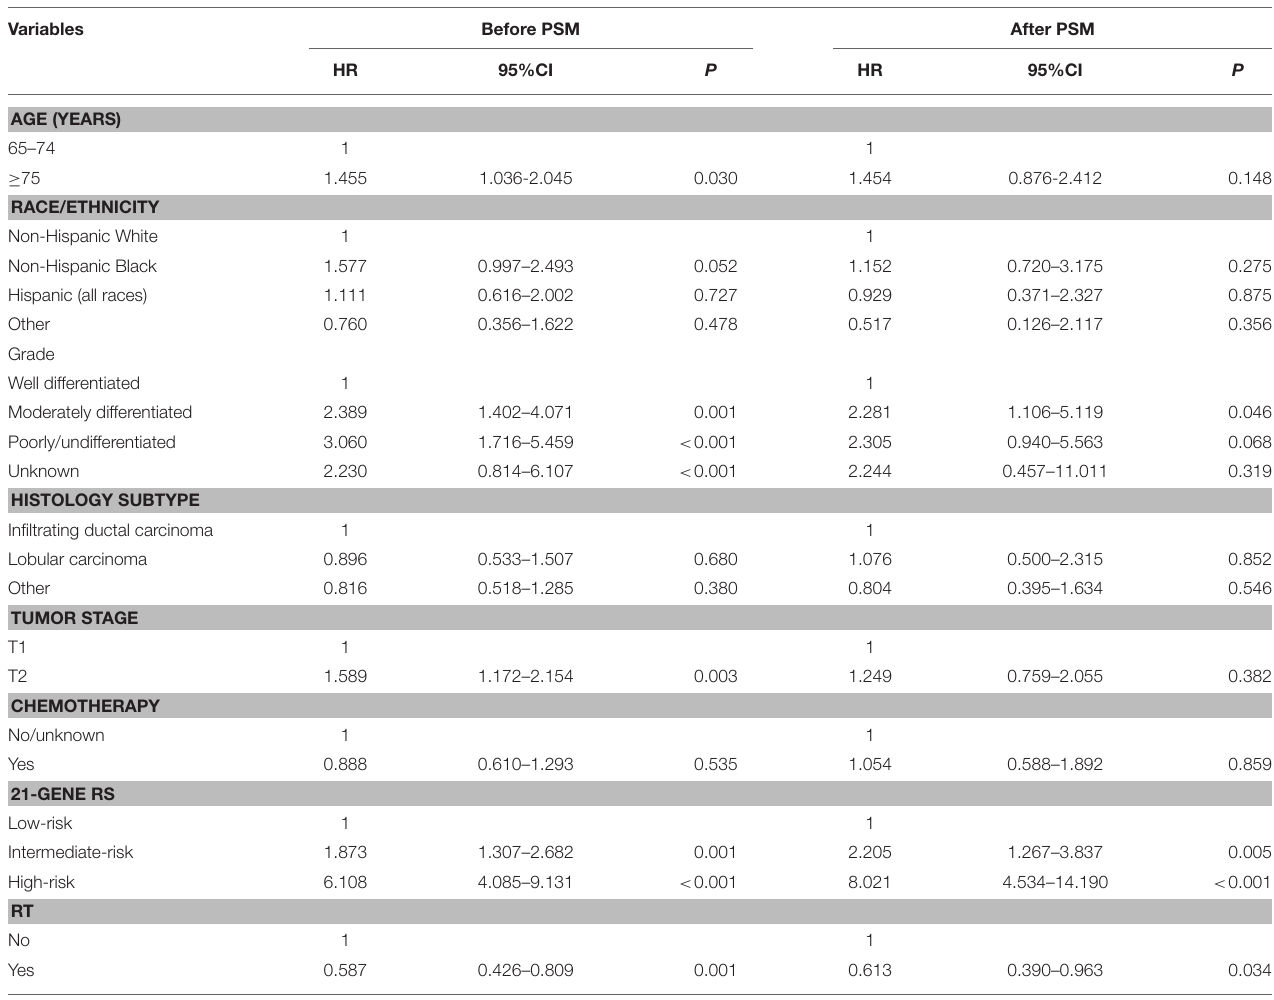
TABLE 2 | Multivariate prognostic analyses before and after propensity score matching.